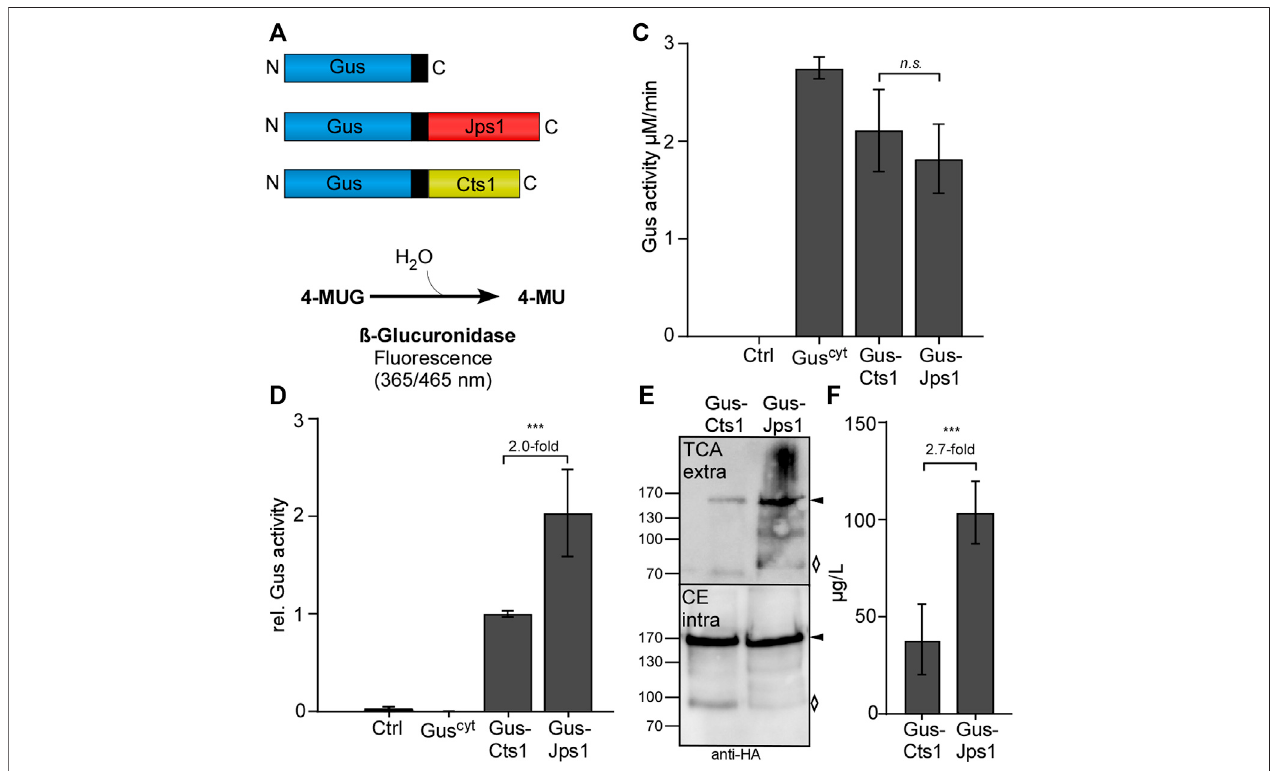
FIGURE 1 | Jps1 is unconventionally secreted and serves as an alternative carrier for Gus export. (A) Schematic display of the proteins expressed to study unconventionalsecretion.CytoplasmicGus(Gus cyt )isusedasalysiscontrol(top).Gus-Jps1(middle)andGus-Cts1(bottom)harbortherespectivecarrierproteinsatthe C-terminus. All proteins carry an SHH (double Strep, ten times His, triple HA) tag indicated in black (Sarkari et al., 2014). All schemes are drawn to scale. (B) Enzymatic reaction mediated by β -glucuronidase. 4-methyl-umbeliferyl- β -D-glucuronide (4-MUG) and H 2 O are converted to 4-methyl-umbelliferone which is a fl uorescent molecule(365 nmexcitation/465 nmemission). (C) DeterminationofintracellularGusactivity.ProgenitorstrainAB33P8 Δ (Ctrl)andAB33Gus cyt expressingcytoplasmic Gus were included as controls. The experiment was conducted in three biological replicates. (D) Comparative extracellular Gus activity of strains using either Cts1 or Jps1 as a carrier. Enzyme activities were normalized to average values of the strain secreting Gus-Cts1. AB33P8 Δ and AB33 Gus cyt were used as a negative and lysis controls, respectively. The experiment was conducted in three biological replicates. (E) Representative Western blot analysis of Gus-Cts1 and Gus-Jps1 secretion. Extracellular protein was enriched from culture supernatants byTCA precipitation. Intracellular protein levels were visualized by cell extracts. Western blots show 1 ml of precipitated supernatants (TCA) and 10 μ g cell extract (CE). Full length protein signal indicated by arrows, degradation bands with a rhombus. (F) Quanti fi cation of secreted protein using Western blot analysis. Supernatants of strains producing Gus-Jps1 or Gus-Cts1 were enriched by TCA precipitation and subjected to Western blot analysis. Signal intensities were compared to de fi ned protein amounts of Multiple Tag protein (GenScript Piscataway, NJ, United States) included in the same gel. Bars show extrapolated protein amounts in µg/L. Westernblots used for the analysis, see Supplementary Figure S3 . Three biological replicates are shown; error bars in fi gures (C) , (D) , and (F) indicate standard deviation. De fi nition of statistical signi fi cance (***): p -value < 0.05. p -value derived from Student ’ s unpaired t -test.